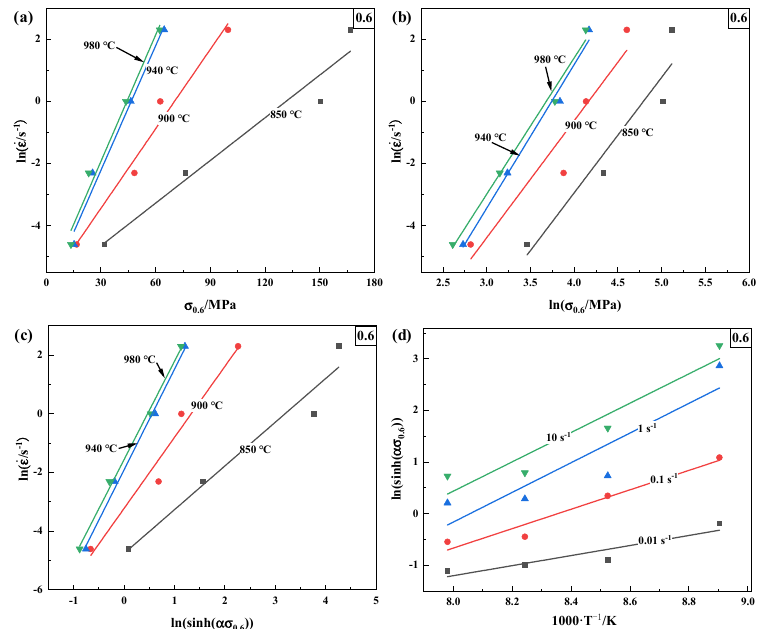
Figure 5. Relationships between the following: ( a ) lnε − σ ; ( b ) lnε − ln σ ; ( c ) lnε −